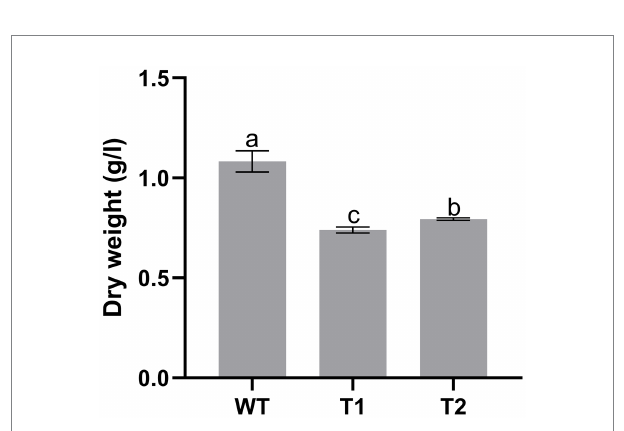
FIGURE 10 Dry weight of wild type and